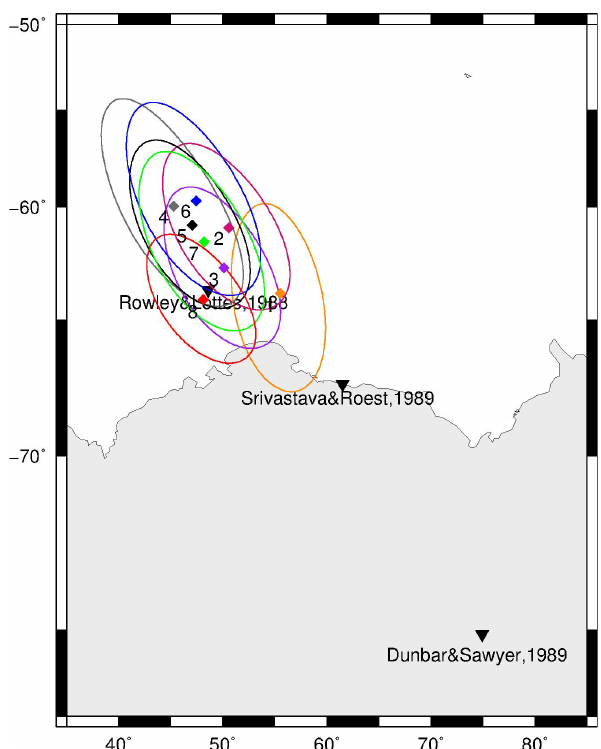
Fig. 14. Comparison of previously published and our computed Eu- ler poles with 95% uncertainty ellipses. The numbers represent the models described in the